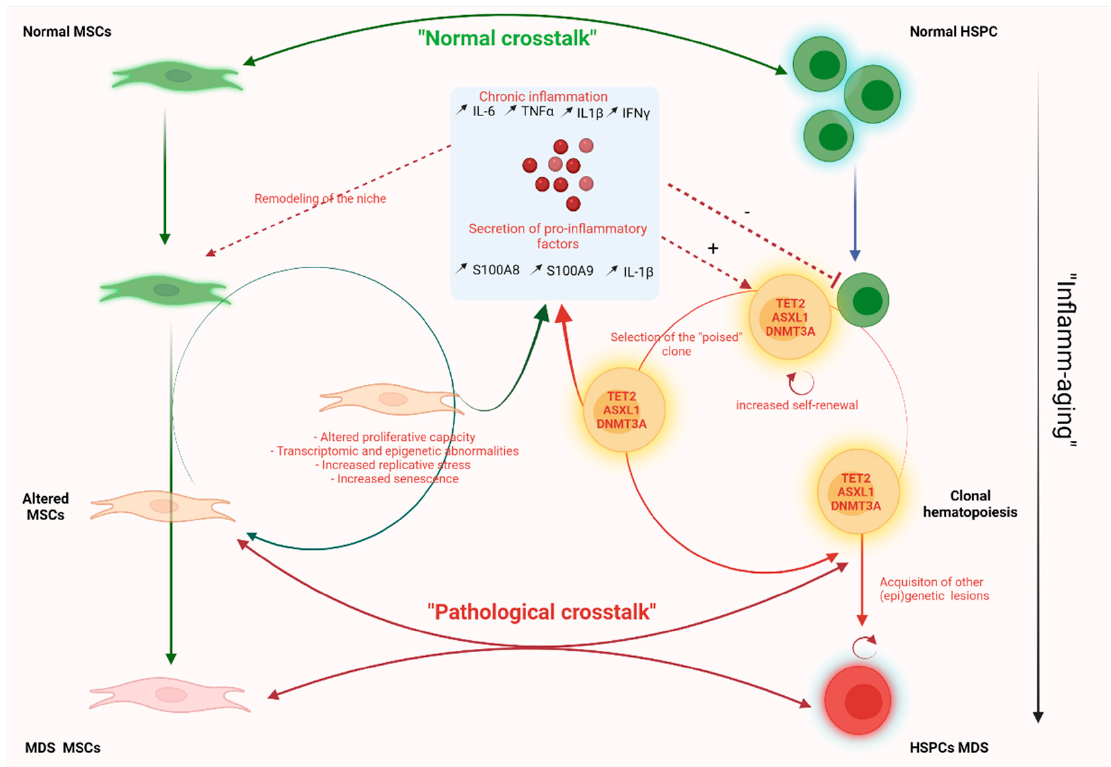
Figure 2. Proposed model explaining the interaction of MSCs and HSPCs in the pathophysiology of MDS. Physiologically, there is a dialogue between normal HSPCs and normal MSCs. During aging, the BMME becomes more inflammatory (“inflamm-aging”) and will favor the expansion of minority clones carrying CHIP mutations ( TET2 , ASLX1 , DNMT3A ). In turn, these selected clones will secrete proinflammatory molecules that will remodel the niche. The “reprogramed” MSCs will in turn secrete pro-inflammatory factors. This pathological crosstalk will progressively amplify and thus promote the appearance of new mutations within the HSPCs and lead to MDS.